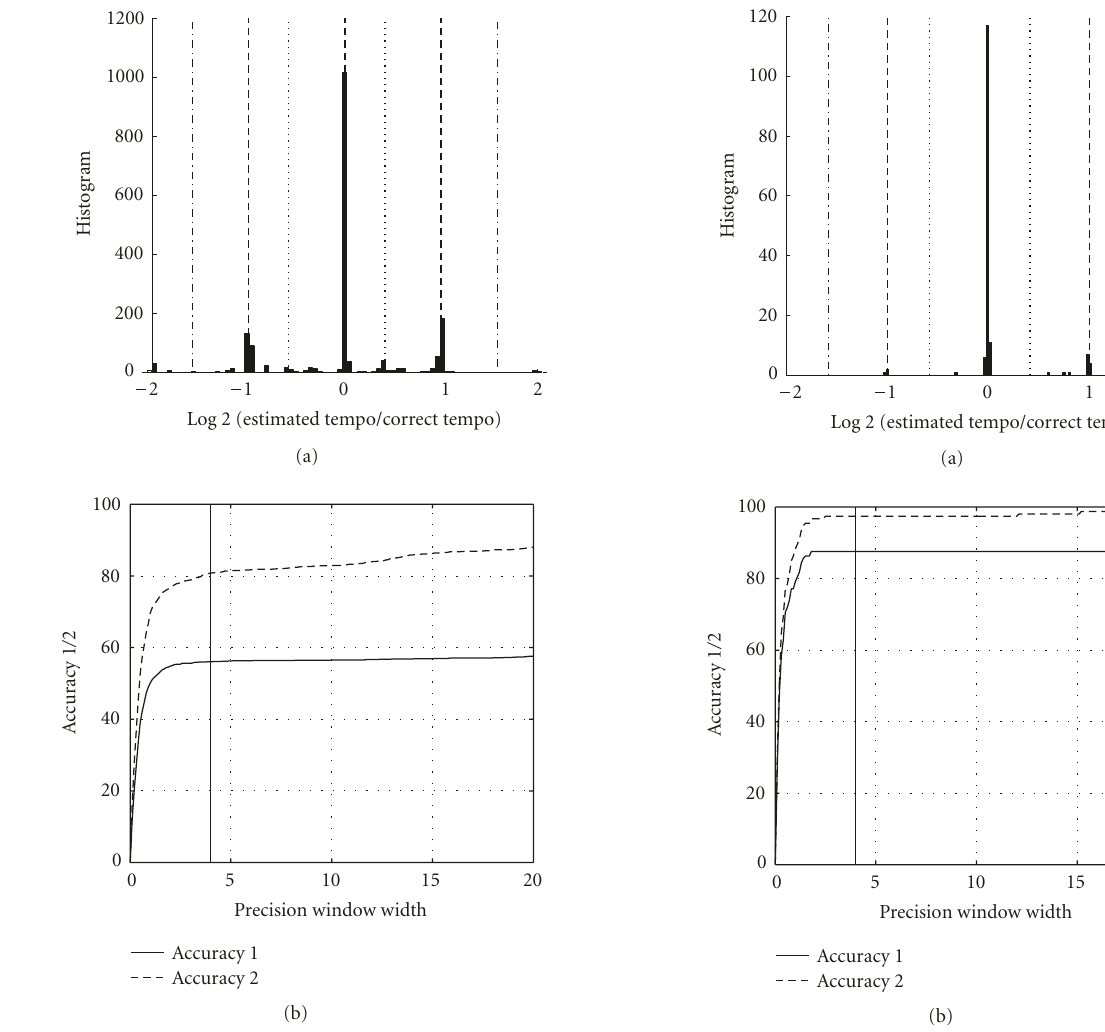
Figure 12: Same as Figure 10 for the loops database. Figure 13: Same as Figure 10 for the poprock